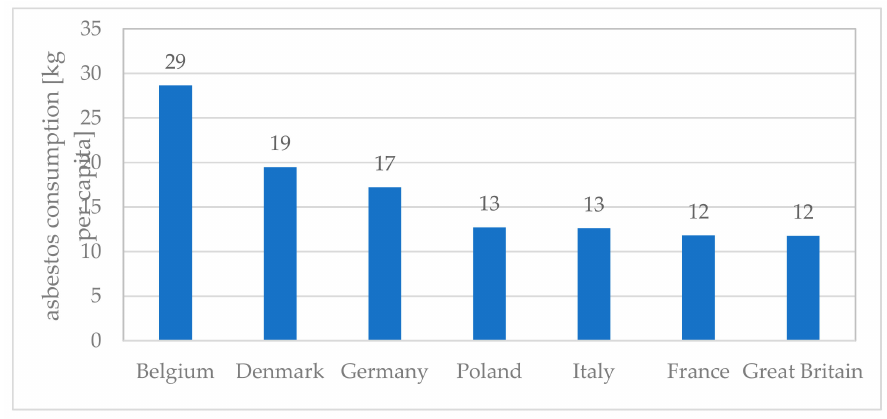
Figure 8. The asbestos consumption per capita in selected European